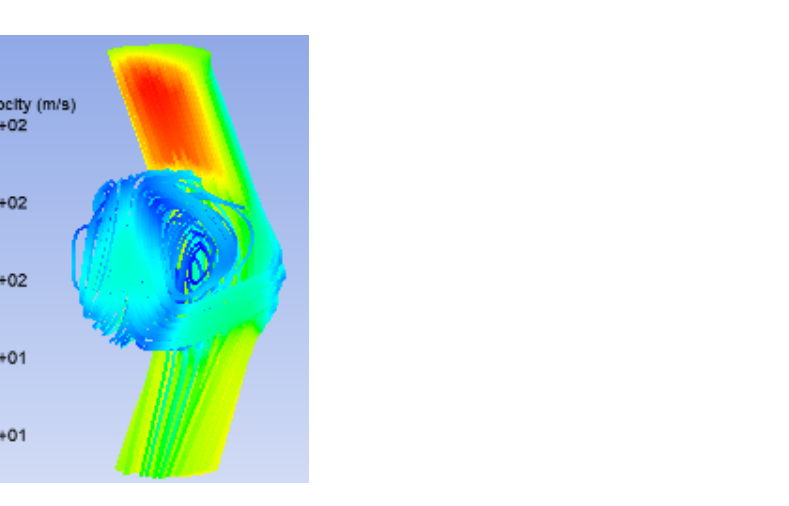
6 of 22 Figure 3. Specific heat (full lines) and thermal conductivity (dash lines) of havar (black lines) and niobium (grey lines) as a function of the temperature. Considering that CFD simulations are time step- or mesh-dependent, the influence of these parameters was studied by using finer meshes and reduced time steps. Simulations of 90 iterations with a time step of 2 s (enabling to reach equilibrium) and the mesh specified in Table 1 were found to present consistent results, while requiring less demanding computational efforts. More details can be found in [23].